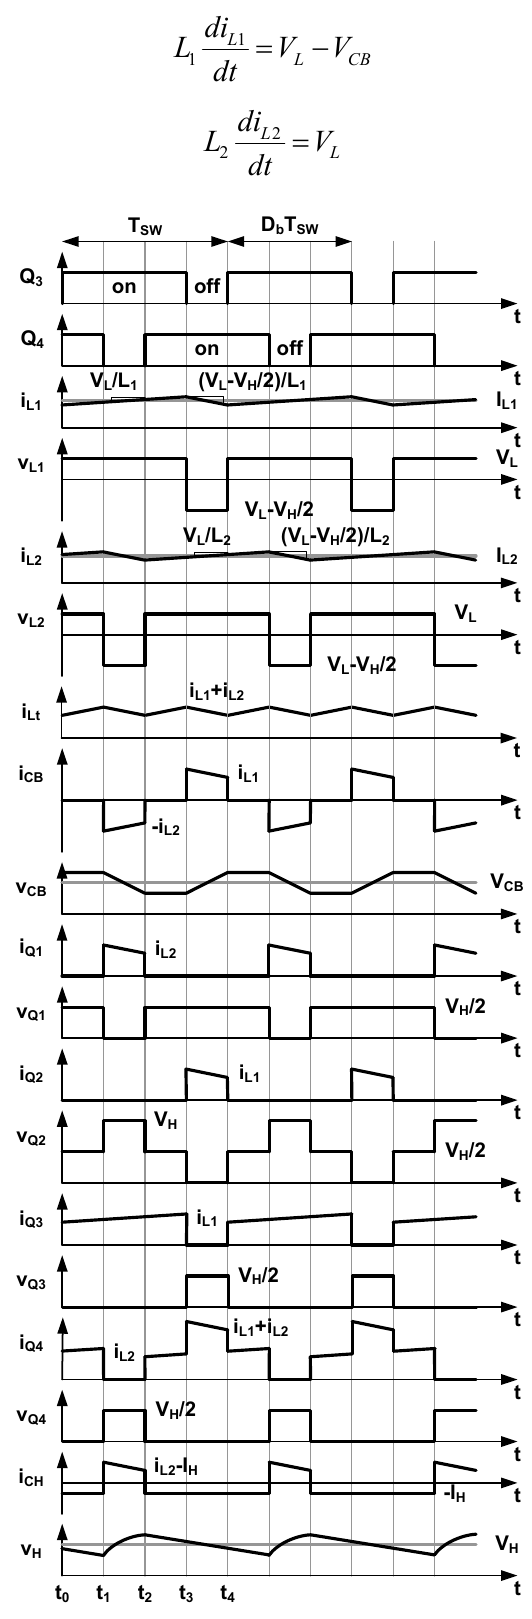
Figure 7. Typical waveforms of the proposed converter in the discharge mode